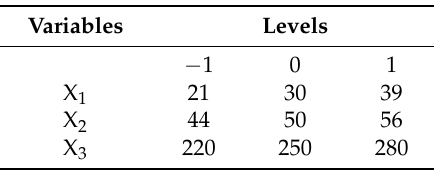
Table 6. Uncoded and coded levels of the independent variables used to extract the volatile oil from P. emarginatus